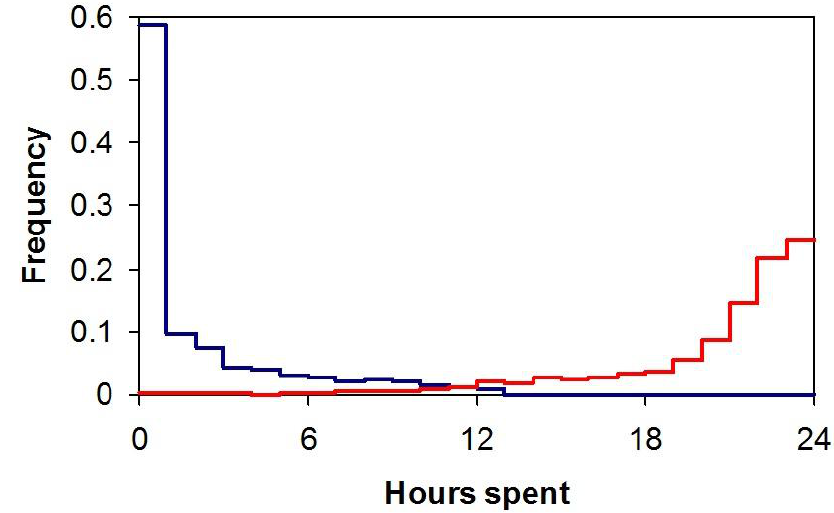
Figure 2. The distribution of times spent indoors (red) and outdoors (blue) by respondents in the National Human Activity Pattern Survey (NHAPS) study [3].